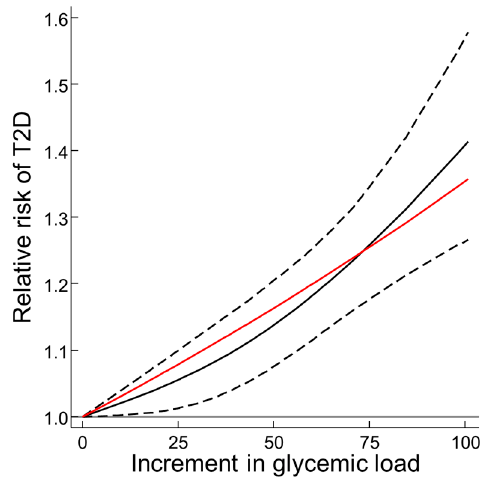
Figure 2. Local dose-dependence of the relative risk of T2D on Glycemic Load in prospective cohort studies combined. Analysis was on the log RR and is shown exponentiated to RR. All studies had a validity correlation coefficient for their dietary instrument of > 0.55 for carbohydrate and reported by 3 or more quantiles. The slope (black continuous line) and 95% confidence intervals (dashed lines) derived from restricted (natural) cubic spline meta-regression ( glst ) with three knots at 0, 34 and 84 increments in GL (per 80 g/d in 2000 kcal (8400 kJ) diet). For comparison a log-linear dose response is also shown (red). There was no significant evidence for departure from log linearity ( P > 0.194 for the secondary spline determinant). Thus the plots (red compared with black) overlapped. Observations were truncated at 100g GL / d in 2000 kcal due to scarcity of increments above this value. The log-linear dose-response T2D-GL risk relation increased by 27% per 80 g GL/d in 2000 kcal diet. RR was 1.27 (1.19–1.36) ( P < 0.001, n = 13). The cubic spline curve reached 1.42 (1.27–1.59) for a 100 g